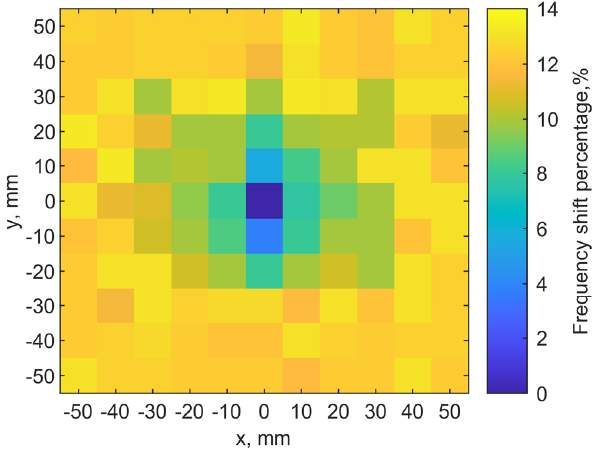
Figure 15. Localization result from measurements with the implant in a depth of 6 mm. The im- plant is located at (0, 0).